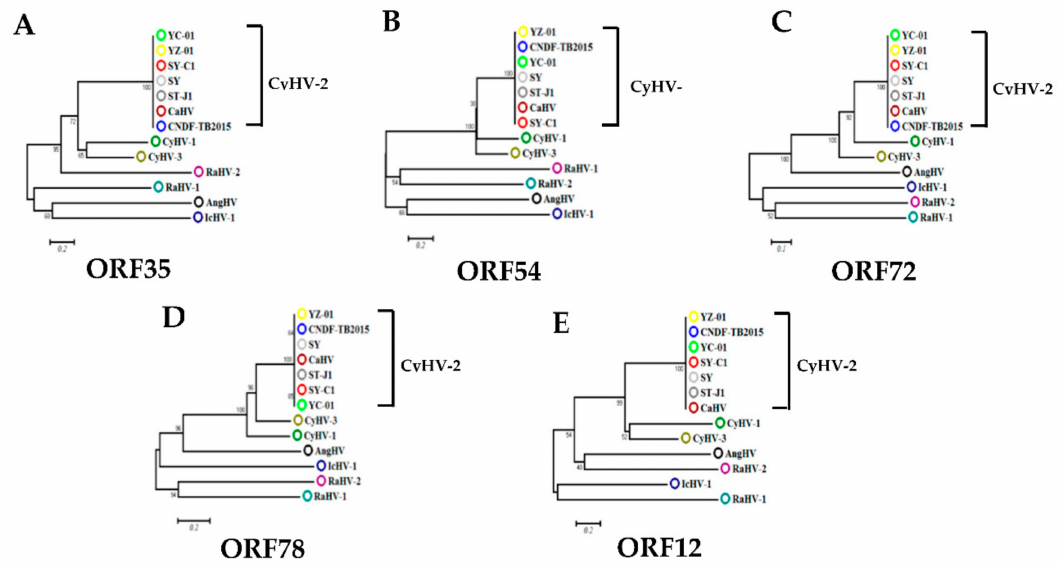
Figure 3. Phylogenetic analysis of five ORFs from CyHV-2. The Phylogenetic trees ( A – E ) were constructed using the neighbor-joining method in MEGA7 based on five ORFs from CyHV-2 (SY (GenBank accession no. KT387800), ST-J1 (NC_019495), SY-C1 (KM200722), CaHV (KU199244), YC-01 (MN593216)), CyHV1 (NC_019491), CyHV3 (NC_009127), AngHV1 (Anguillid herpesvirus-1; FJ940765), RaHV1 (Ranid herpesvirus-1; NC_008211), RaHV2 (Ranid herpesvirus-2; NC_008210), and IcHV1 (Ictalurid Herpesvirus 1; NC_001493). Branch lengths are proportional to evolutionary distance showing the divergence among di ff erent species.